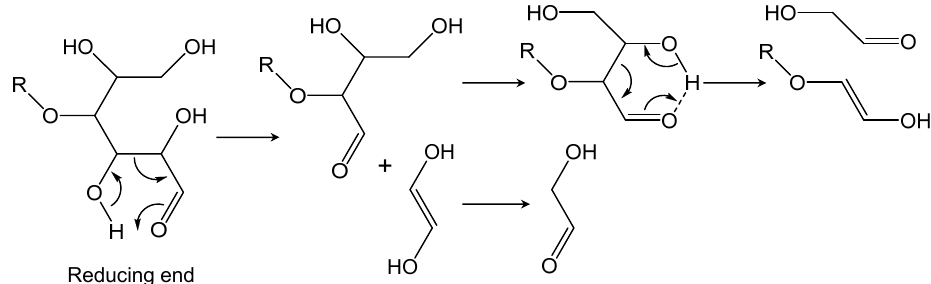
Figure 7. Mechanism for the formation of GA from the reducing ends of cellulose and other interme- diate carbohydrates during the fast pyrolysis of cellulose.